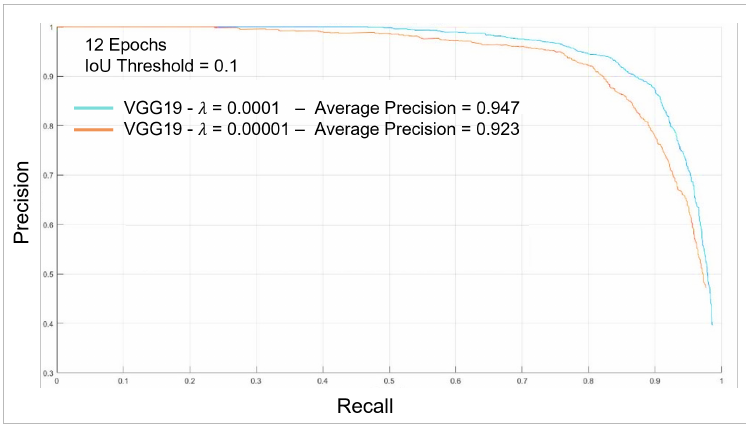
Figure 24. Recall–precision curve for VGG19 networks trained for 12 epochs. IoU threshold =